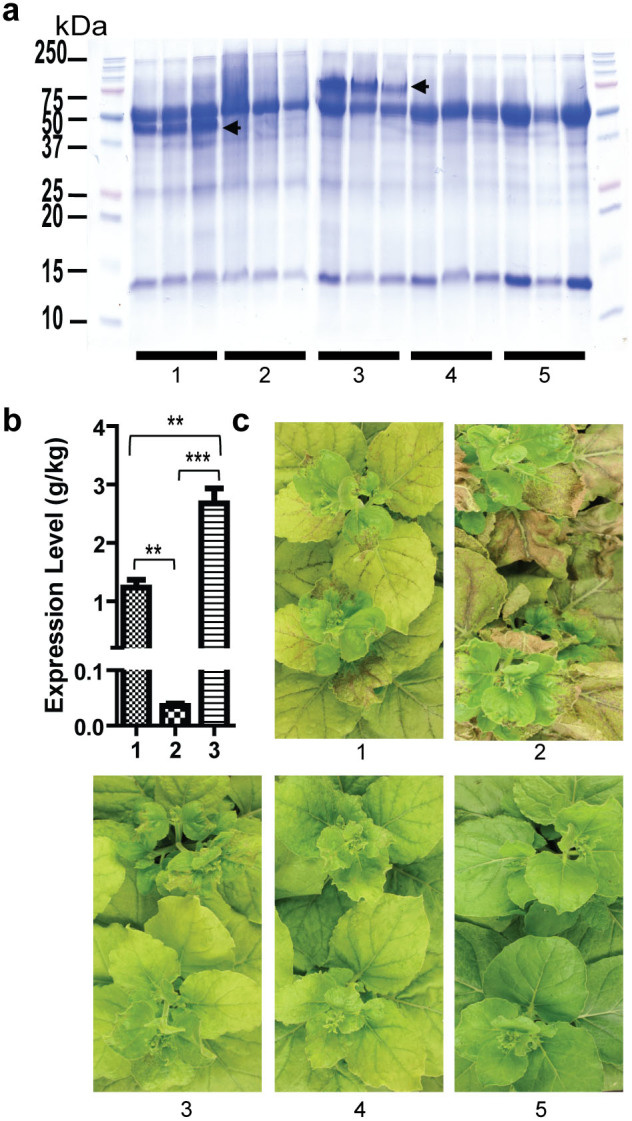
Comparison of gCTB, N4S-CTB, and N4S-CTB-KDEL at 5 dpi.(a) A Coomassie-stained non-denaturing SDS-PAGE resolving crude N. benthamiana leaf extracts. Numbers correspond to: 1. N4S-CTB-KDEL-expressing; 2. N4S-CTB-expressing; 3. gCTB–expressing; 4. empty vector-infiltrated; and 5. non-infiltrated plants, respectively, in biological triplicate (three independent plants). Arrowheads indicate N4S-CTB-KDEL and gCTB pentamers. (b) Quantification of CTB in leaf extracts at 5 dpi by GM1-ELISA. Numbers 1-3 correspond to N4S-CTB-KDEL, N4S-CTB and gCTB, respectively. Data are expressed as means ± SEM in biological triplicate. **P < 0.01, ***P < 0.001 (ANOVA with Bonferroni's multiple comparison test). (c) Photographs showing the phenotype of vector-inoculated plants at 5 dpi. Numbering is the same as in (a). Severe necrosis is evident with N4S-CTB and, to a lesser extent, N4S-CTB-KDEL, but not with gCTB.